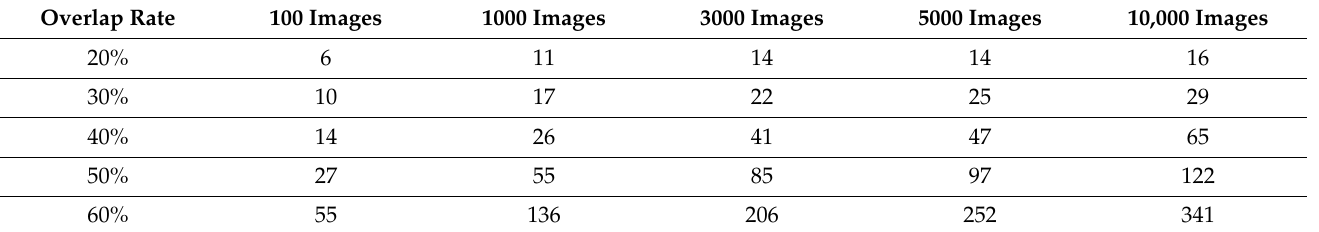
Table 1. Number of memory patterns compared to SDR overlapping rate.